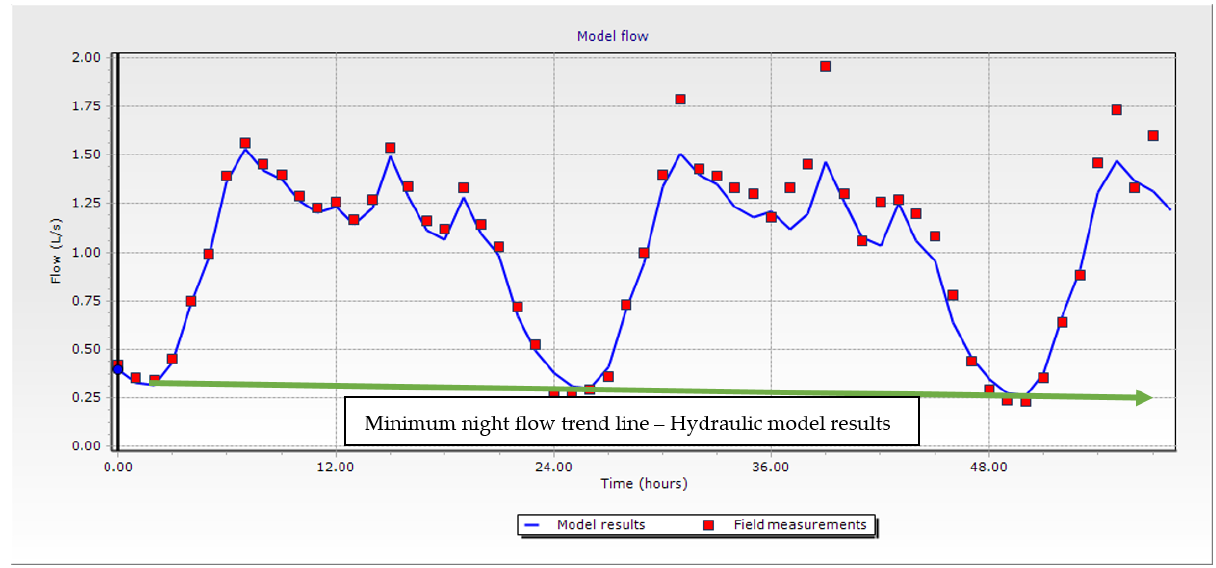
Figure 7. The resulting MNF trend line using hydraulic model calculation (blue line represents theoretical flow derived from hydraulic model, while red points represent measured values). matches with average difference in MNF of 0.01 l/s or 4% compared to measured data.